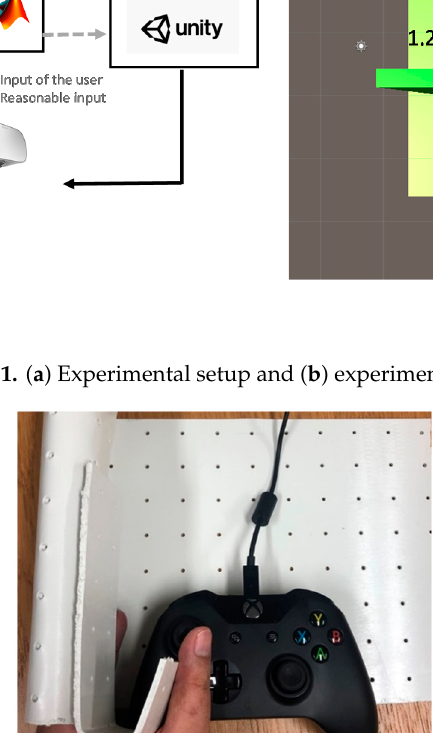
Figure 12. Use of a restraining device to reproduce the insufficient input scenario.